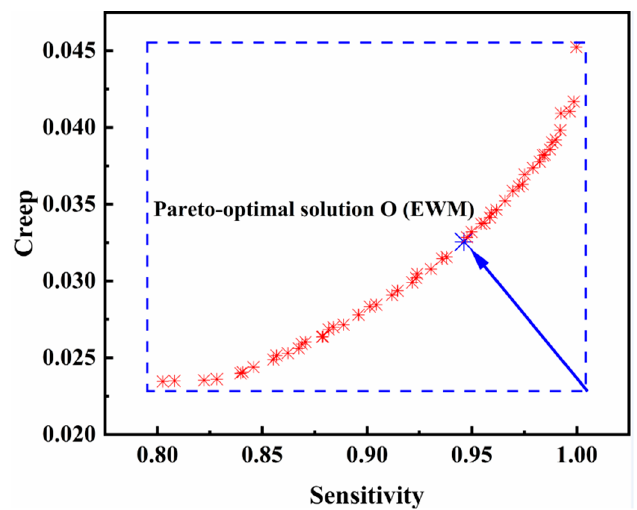
Figure 14. Pareto optimal solution.